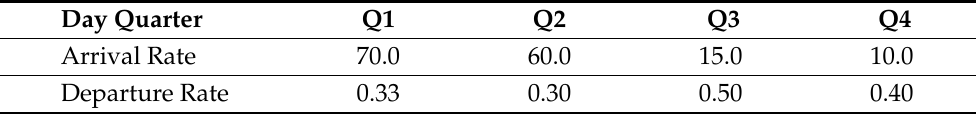
Table 3. Historical arrival and departure rates of